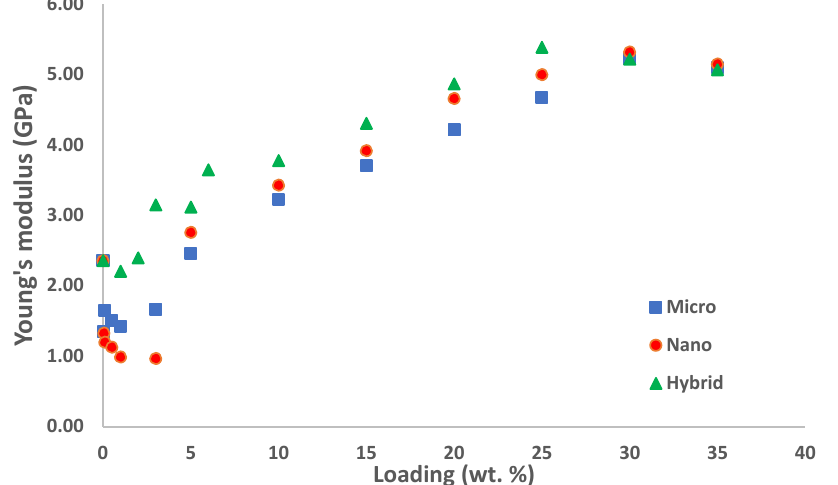
Figure 4. Comparison of Young’s Modulus values between Micro, Nano, and Hybrid Silica.